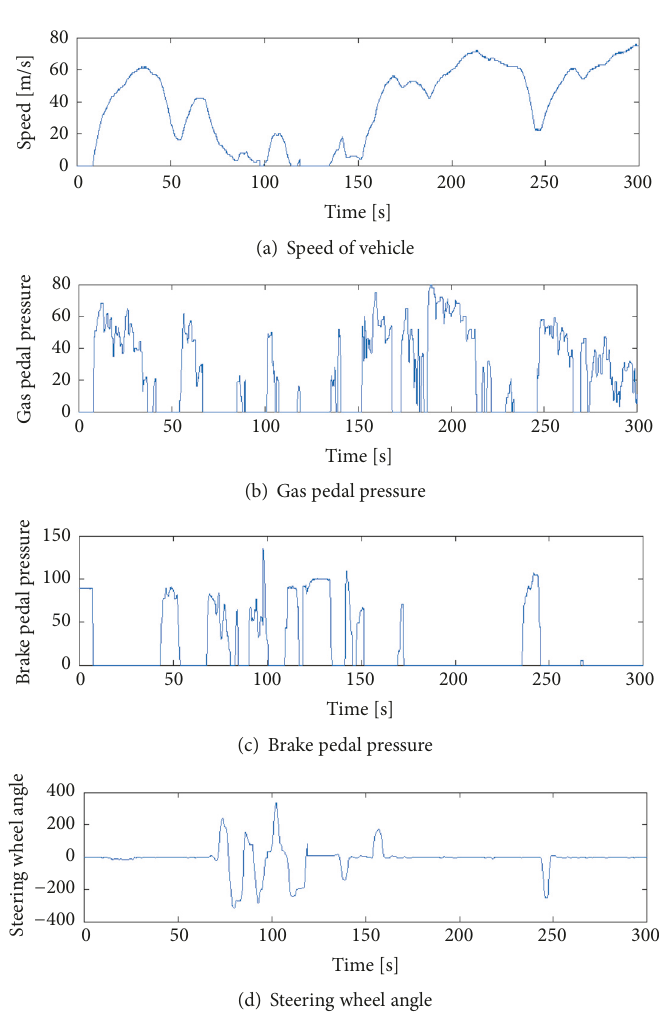
Figure 3: Examples of driving behavior signals collected in 300 seconds of normal driving. (a) Speed of vehicle; (b) gas pedal pressure; (c) brake pedal pressure; (d) steering wheel